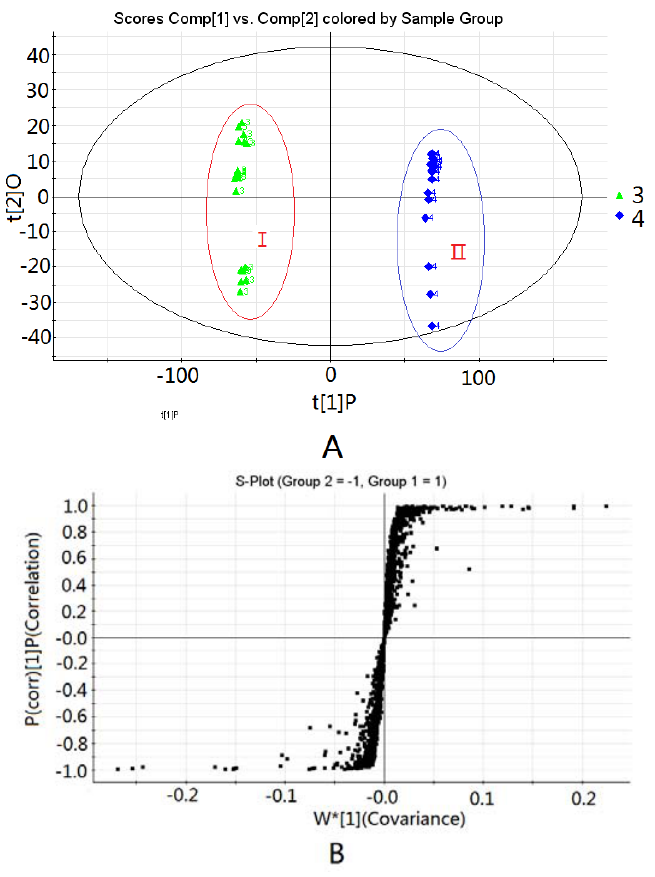
Figure 3. ( A ) OPLS-DA score plot and ( B ) S-plot obtained from the groups of RAK